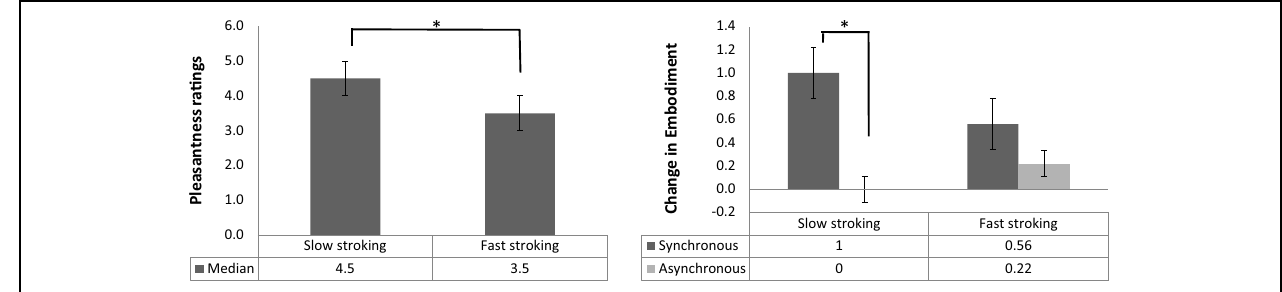
FIGURE 2 | (A) Median and interquartile range (error bars) of pleasantness rating scores for slow and fast stroking. (B) Median and interquartile range (error bars) of change in embodiment of the rubber/real hand for synchronous (dark gray bars) and asynchronous (light gray bars) stroking, panels (A,B) : ∗ p < 0 .